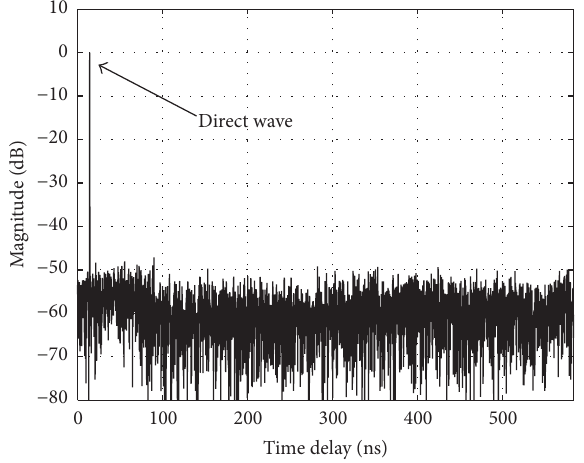
Figure 8: Magnitude of a calibrated CIRF.